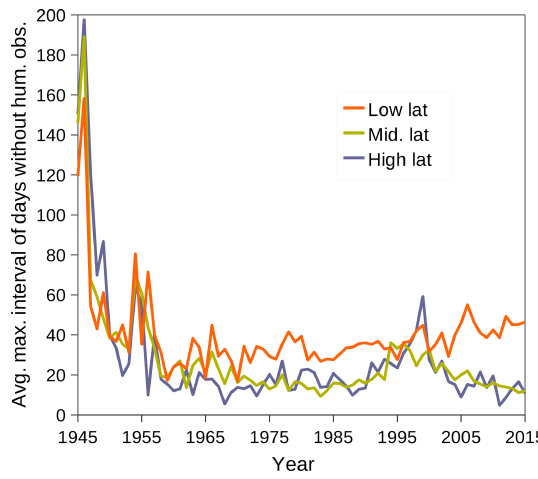
Figure 7. Maximum number of consecutive days without humidity data in each year with some humidity observations (“size of missing days”), averaged among the fixed stations within each of the major latitude regions defined as in Fig.